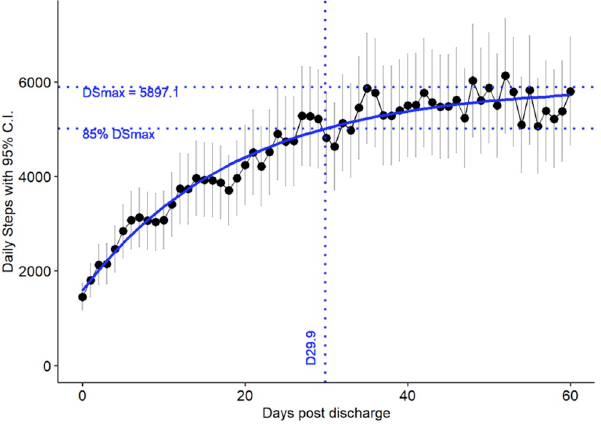
Fig 2. Daily steps performed after cardiac surgery. Black points = mean daily steps plus variability ( ± 2SD) as shown by vertical lines. Blue curve = best fit regression, r 2 = 0.97. DSmax: Extrapolated maximum of daily steps.